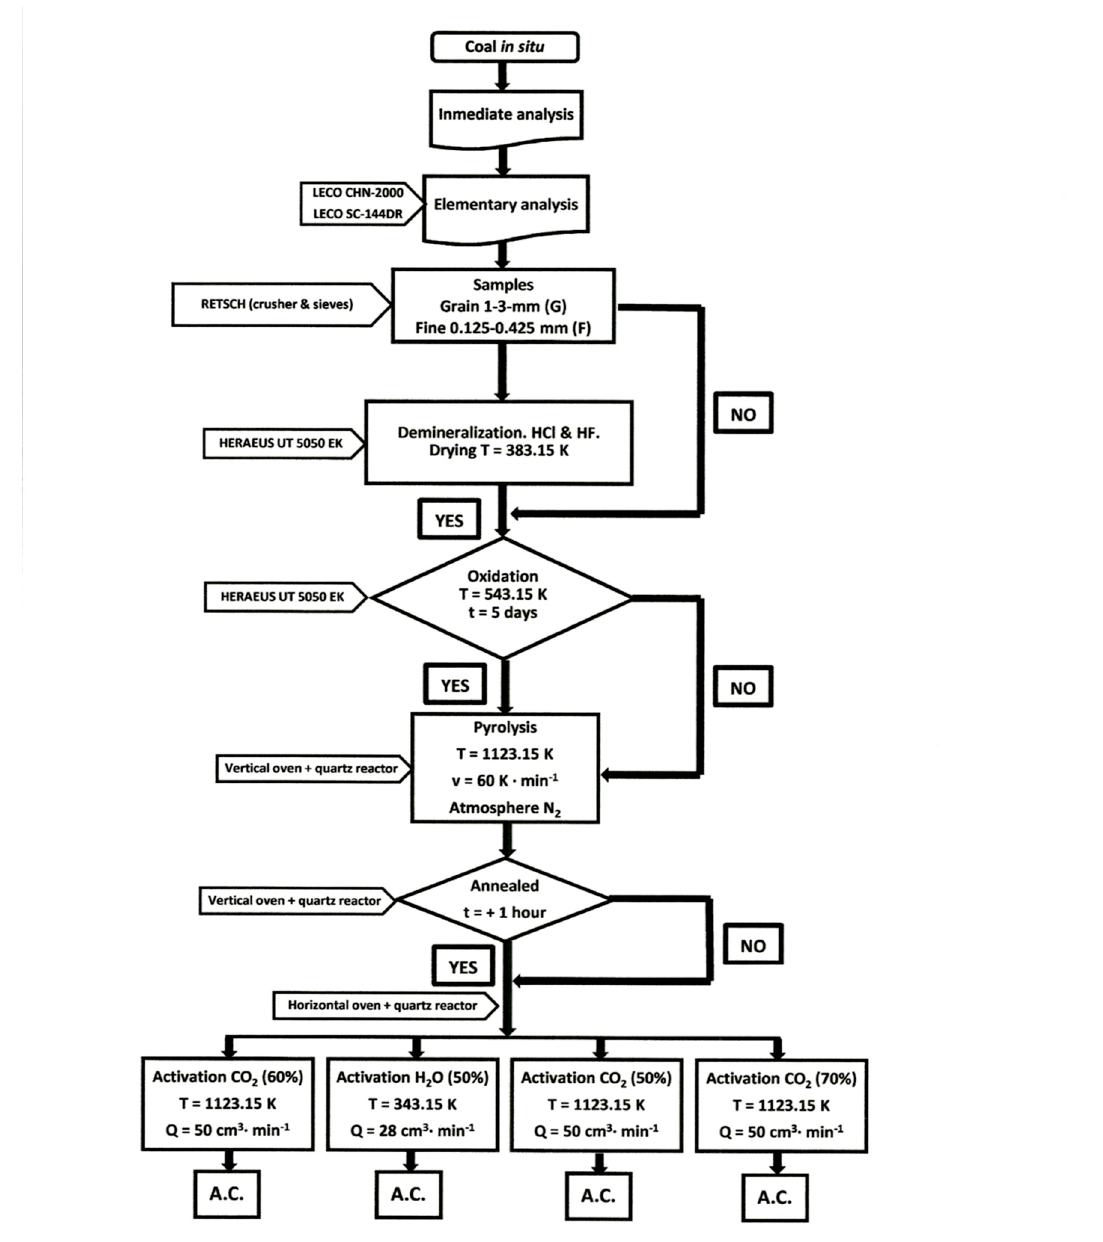
Figure 4. Diagram of process and